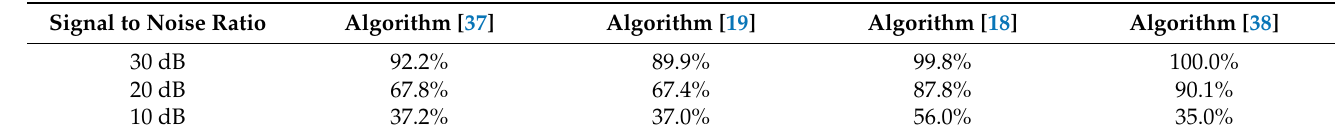
Figure 17. Comparison of normalized fingerprint characteristics of five individuals. Table 8. Fingerprint feature identifiability test results of simulation model data.